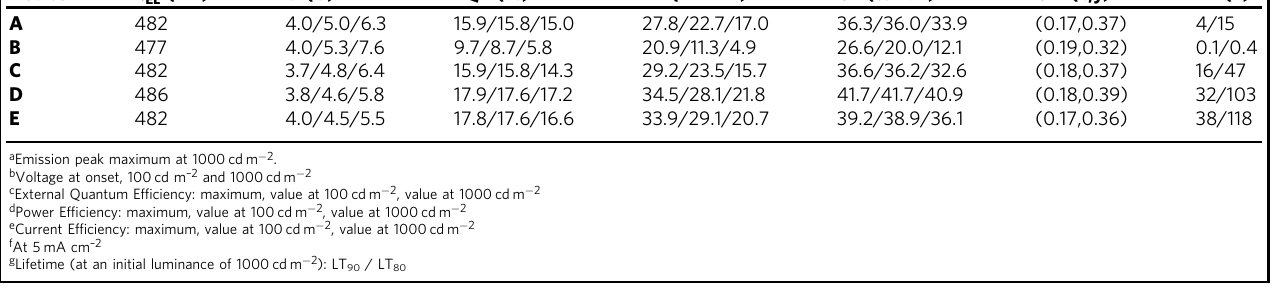
Table 2 Device performance of OLEDs based on 3Ph 2 CzCzBN and 4CzBN